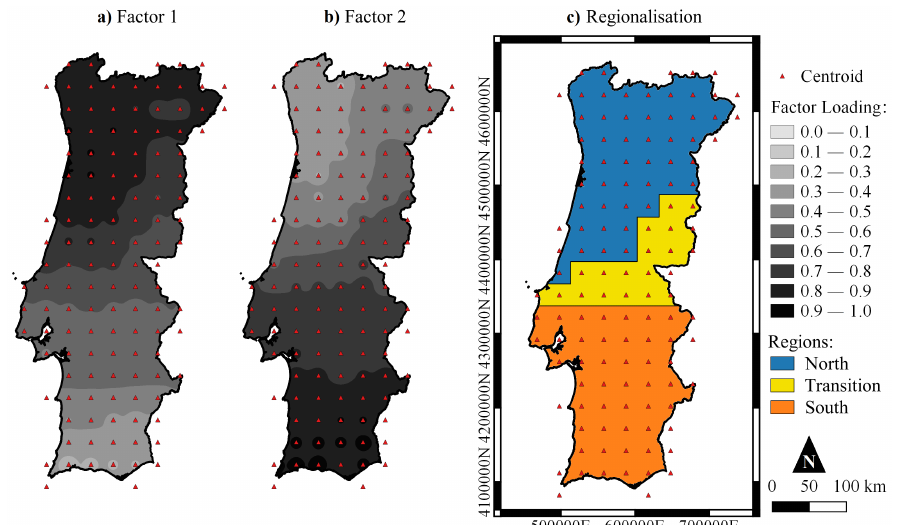
Figure 7. Factor loadings (correlation between observed variables and latent common factors) for the annual 126 gridded rainfall series (1919–2019) in ( a ) Factor 1 and ( b ) Factor 2. ( c ) Region- alisation of three identified climatic regions based on factor analysis, namely, north, transition, and south—coordinates WGS84 (UTM zone 29N), IDW2 interpolation method used for mapping the factor loadings.